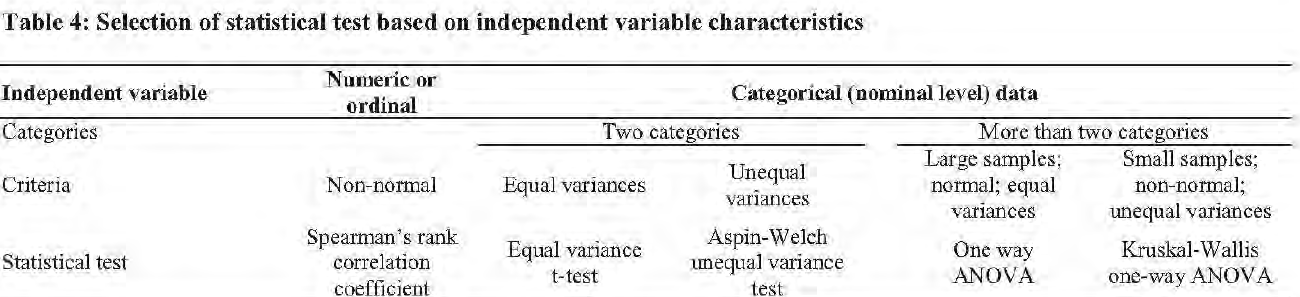
Table 4: Selection of statistical test based on independent variable characteristics Independent variable